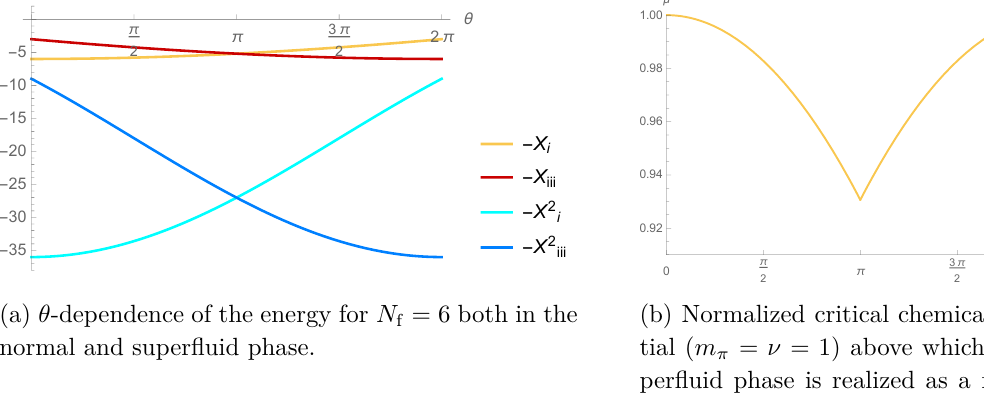
(b) The CP order parameter (cid:10) F ˜ F (cid:11) as a function of θ in the superfluid phase for different values of the chemical potential: µ = 5 , 10 , 15 . We consider m = ν = 1 . π